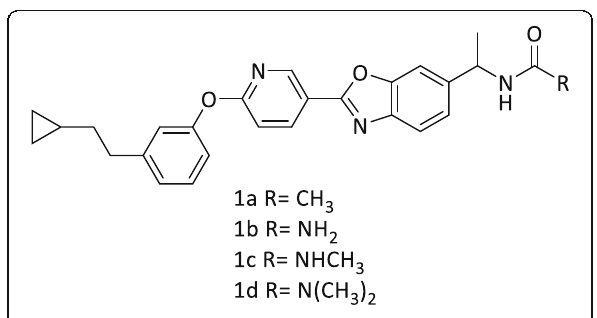
Fig. 38 Benzoxazole as ACC1 inhibitor